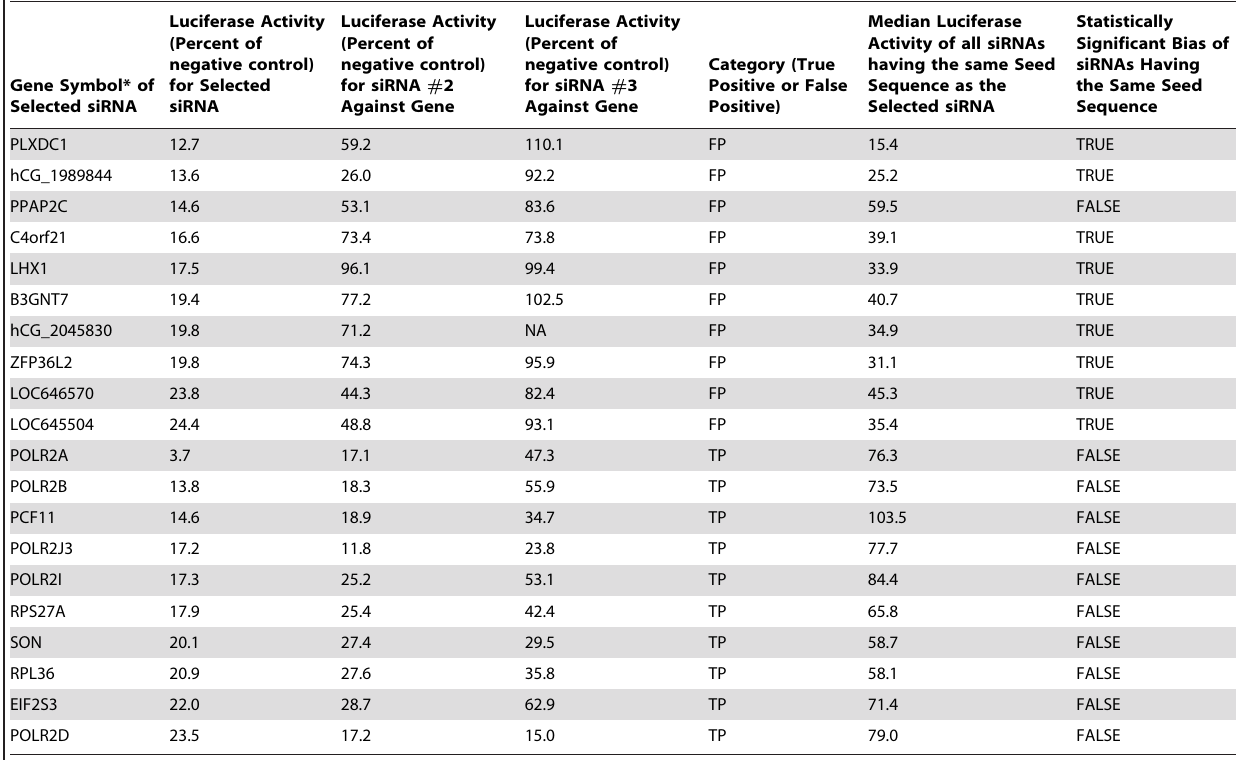
Table 1. siRNAs Selected as True and False Positives.